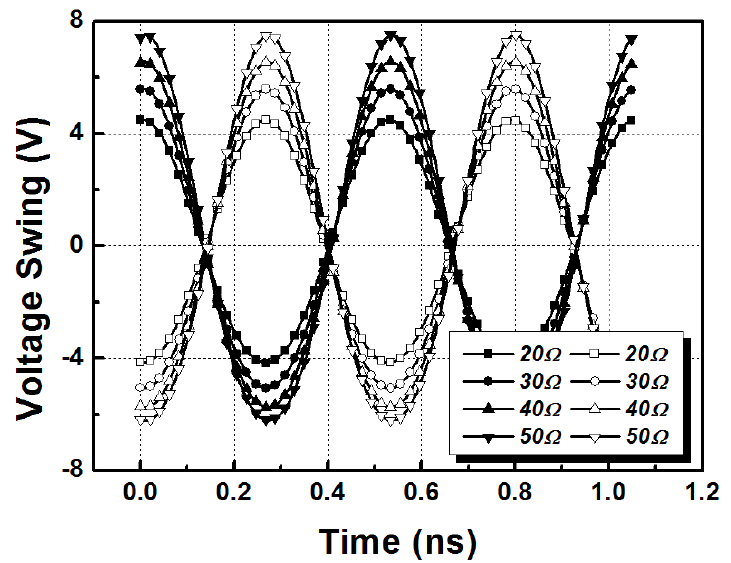
Figure 2. Simulated voltage swing over each single-ended switch (vacant symbols are for path1, and solid symbols are for path2, 33 dBm of input power is applied at 1.9 GHz).